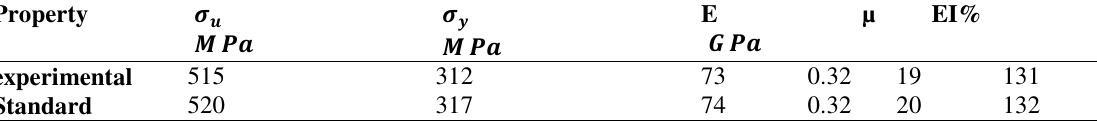
Mechanical properties of 7049AA Property